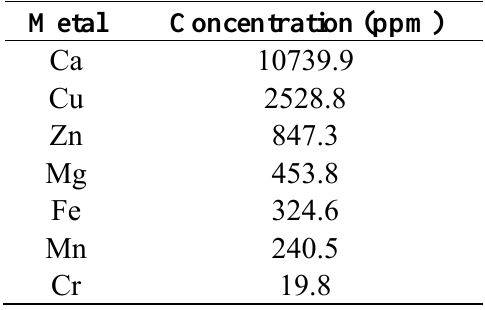
Table 3. Metal content of PAA determined by plasma spectrometry.